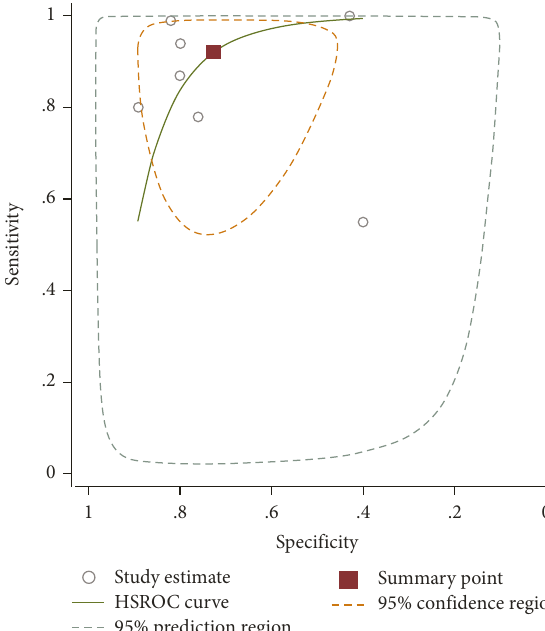
Figure 6: SROC curve included studies in the meta-analysis of the association of the NLR with